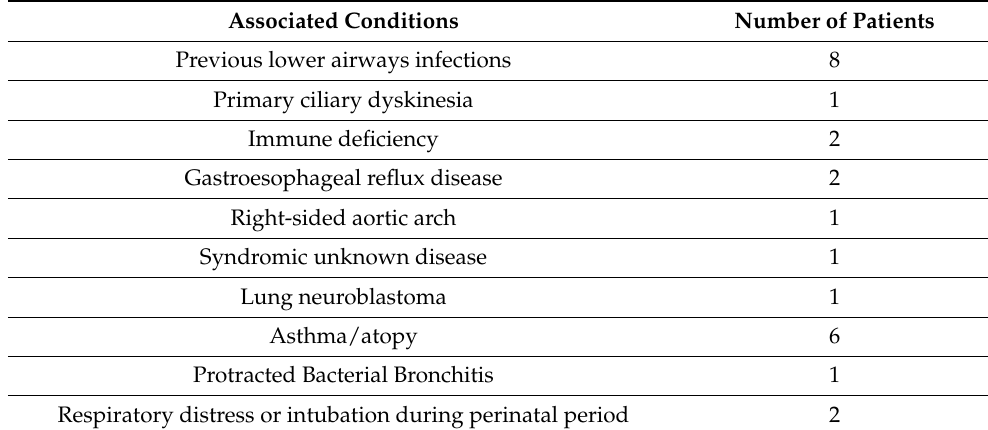
Table 1. Associated conditions. Some patients have more than one associated condition.